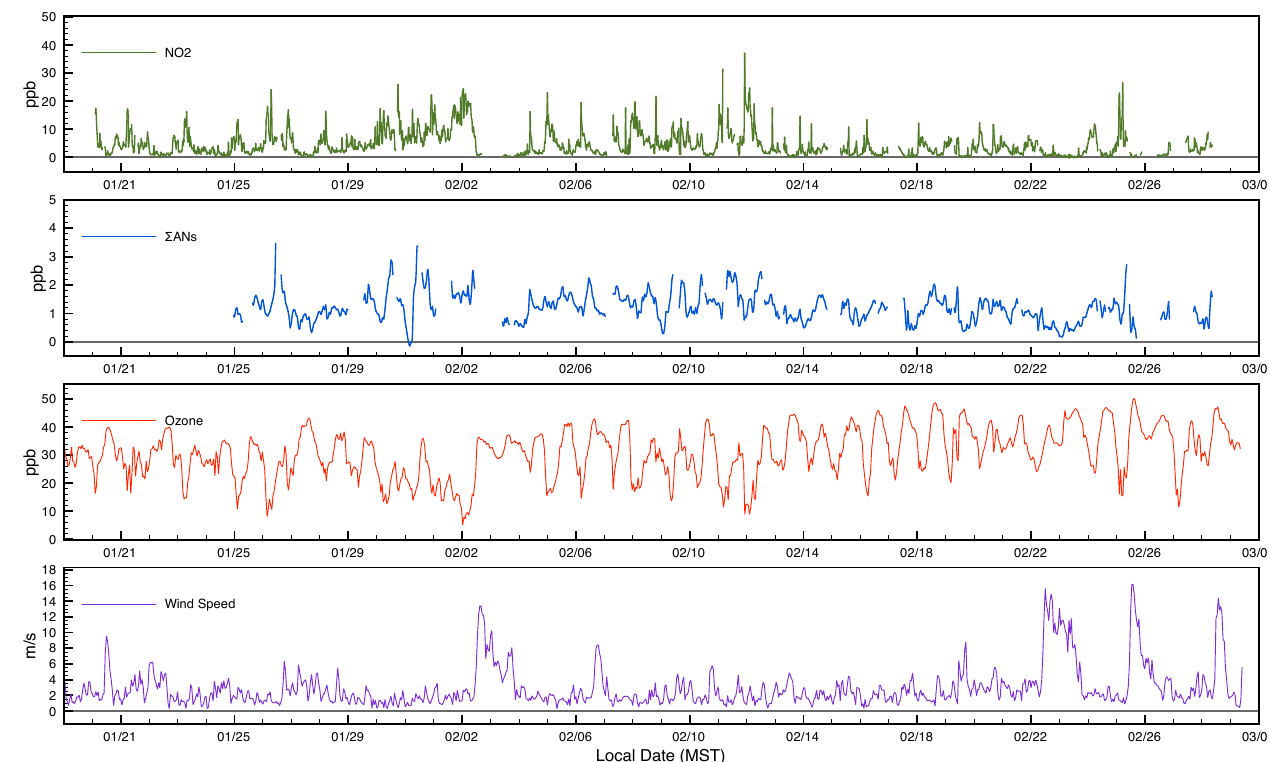
Figure 1. Hourly-averaged time series of NO 2 , total alkyl nitrates ( (cid:54) ANs), O 3 , and wind speed measured during UBWOS 2012. The concentrations are measured at a height of 16m from a 19m scaffolding tower on site. The wind speed is measured at the tower’s top. Ticks on the x axis mark local